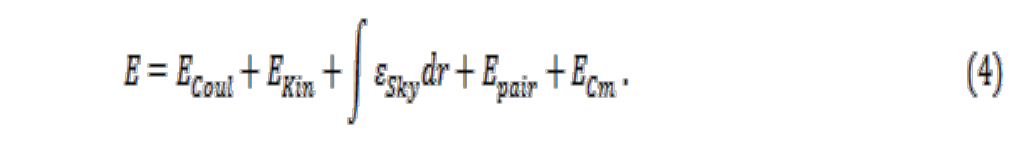
Table 1: The values of Skyrme